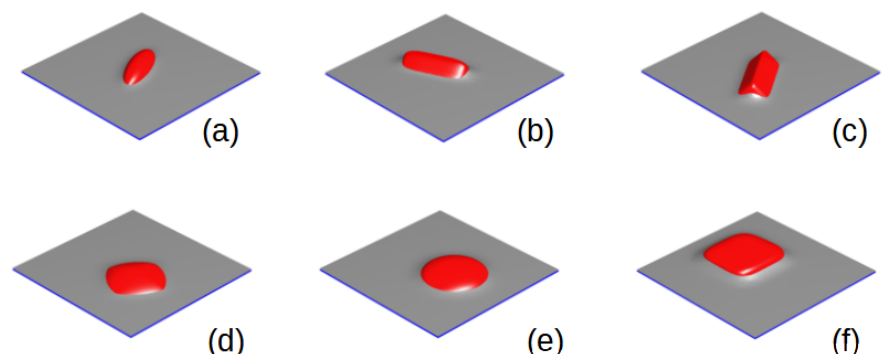
Figure 5. Assembly at a flat interface of neutral NPs with various shapes controlled by the super- ellipse parameter. The parameters are grouped as ( a , b , c , n ) for the three semiaxis and the exponent n , respectively: ( a ) ( 8,3,3,1 ) ; ( b ) ( 8,3,3,2 ) ; ( c ) ( 8,3,3,4 ) ; ( d ) ( 3,8,8,0.75 ) ; ( e ) ( 3,8,8,1 ) and ( f ) ( 3,8,8,2 ) .